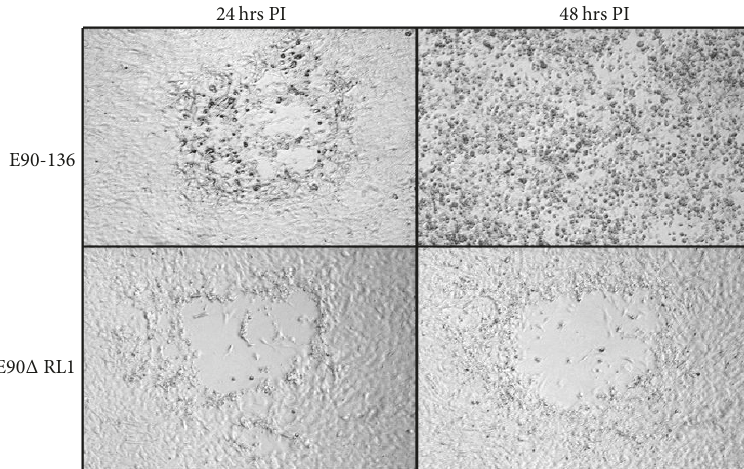
Figure 4: Deletion of the RL1 region affects BV spread in primary mouse cells. Primary murine skin fibroblast cells were prepared, cultured, and infected as described [26]. At low MOI (0.3 PFU/cell) wild-type BV (E90-136) forms plaques by 24hr PI and rapidly spreads over the next 24hrs, while the E90 Δ RL1 deletion mutant fails to spread after 24 hrsPI.